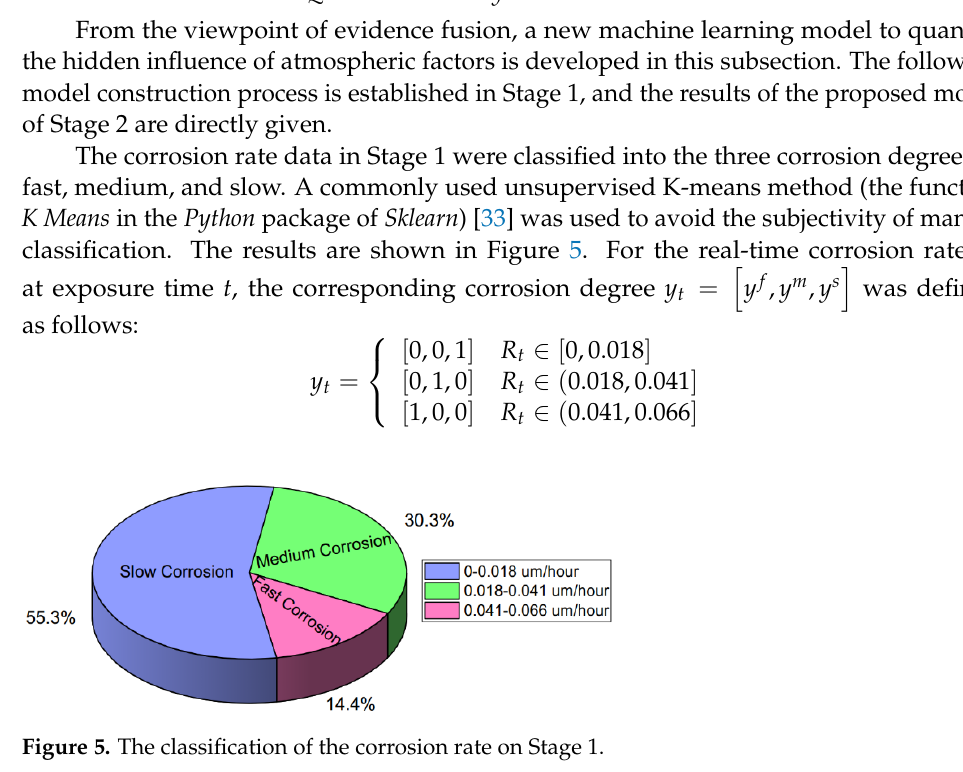
Figure 6. The framework of the proposed model. Step 1: Evidence construction. Let